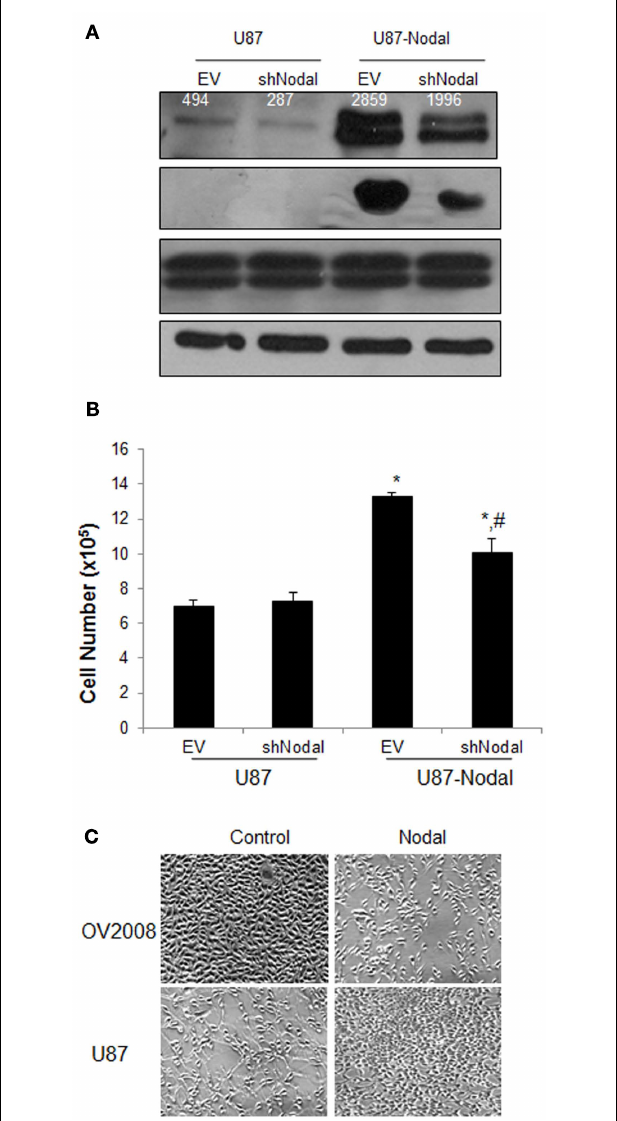
FIGURE 2 | Effect ofNodal overexpression and knockdown on glioblastoma cell proliferation. (A) Four cell lines, U87 transfected with a control empty vector (U87–EV), U87 transfected with Nodal shRNA (U87-shNodal), U87 transfected with Nodal plasmid (U87-Nodal), and 87 transfected with both Nodal expression plasmid and Nodal shRNA (U87-Nodal/shNodal) were generated. Proteins extracted from these cell lines were analyzed byWestern blotting using antibodies against Nodal, phosphor-Smad2 (pSmad2), total Smad2 and Smad3 (Smad2/3), and β -actin as the loading control. Overexpression and activation of Smad2 were confirmed in the U87-Nodal cells. Numbers on the Nodal blot are densitometry readings of the bands. (B) Cell growth assays.The stable cell lines were cultured for 48h and cell numbers were determined by the trypan blue exclusion method. Data represents mean ± SEM ( n = 3).The experiment was done three times and similar results were obtained. * P < 0.01 vs. U87–EV and U87-shNodal, # P < 0.05 vs. U87–EV and U87-Nodal. (C) Comparison of the effect of Nodal overexpression in U87 and OV2008 cells.Two pairs of cell lines, control and Nodal-overexpressing OV2008 and control and Nodal-overexpressing U87 cells, were cultured for 2days before pictures were taken.